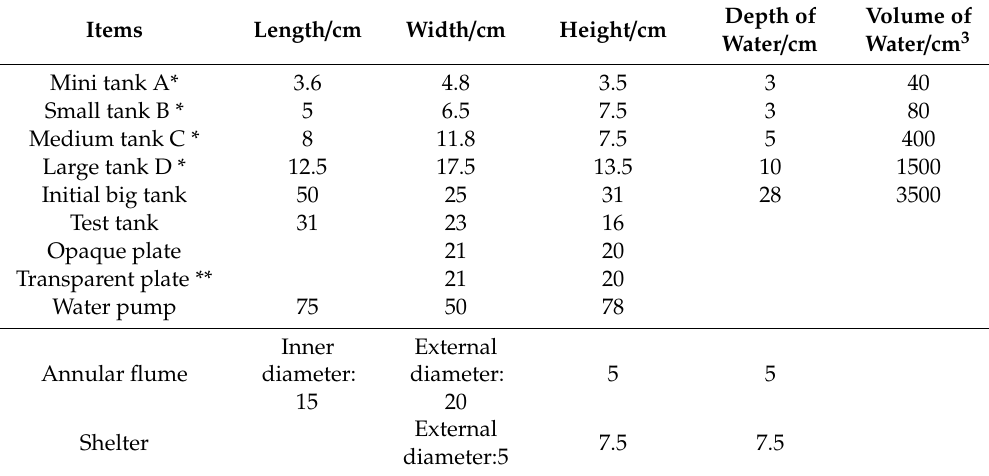
Figure 1. Experimental flow chart: 1. Physiology test for the control group. 2. Three behavior tests for the experimental fish. 3. Experimental fish were classified in four di ff erent groups. 3. Three behavior tests were performed again. 5. Stamina test for experimental fish. 6. Physiology test for experimental fish. Table 1. Experimental